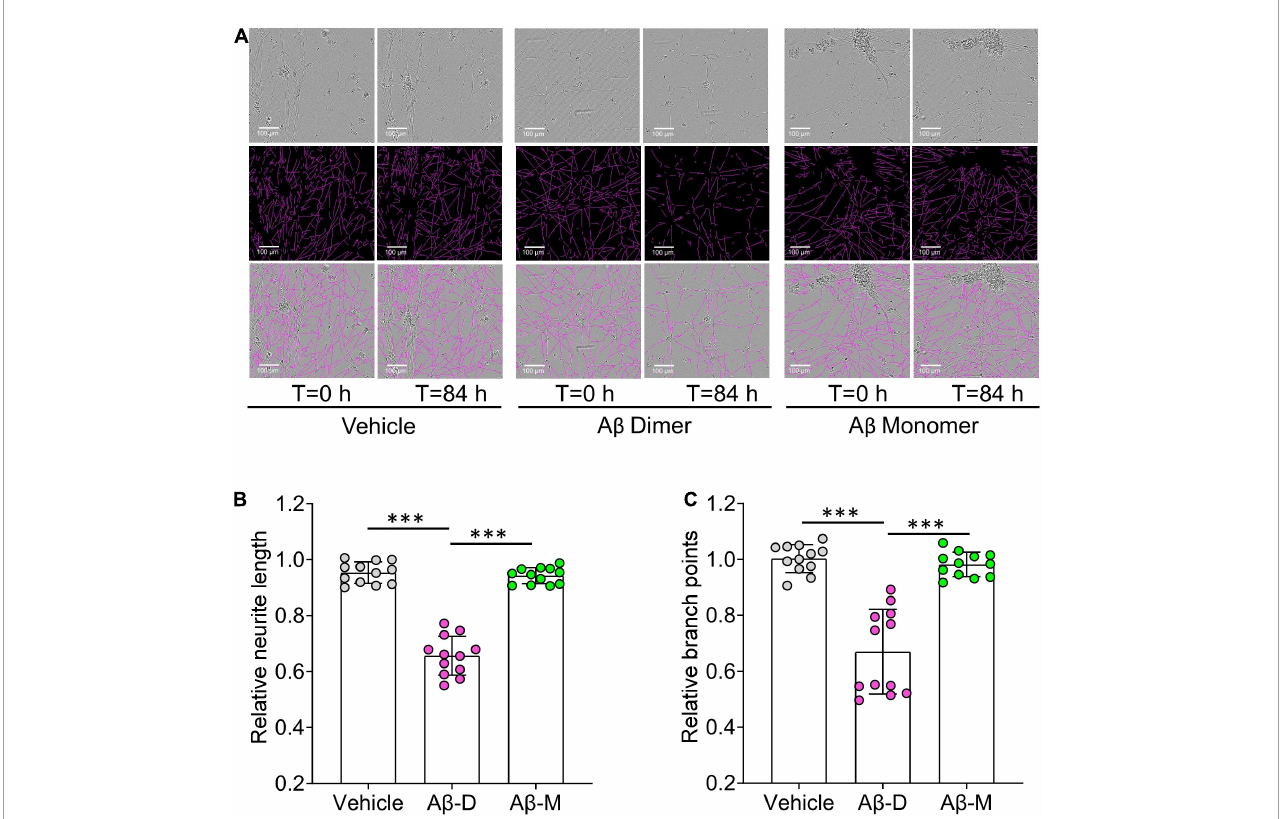
FIGURE6 Human brain derived A β dimers induce neuritic dystrophy when applied to iNs. (A) Mature human iPSC-induced neurons (iNs) were treated with vehicle, 22 nM of AD brain derived A β dimers (A β Dimer) or monomers (A β Monomer), and cells imaged using IncuCyte live-cell imaging instrument for 84 h. Phase contrast images (top panel) were used to identify neurites (middle panel) using NeuroTrack software. Identified neurites (purple) are shown on the phase contrast images (bottom panel). Scare bars are 100 µ m. (B,C) Each well of iNs was imaged for 6 h prior to addition of sample used as baseline. Relative neurite length and branch points at T = 0 and 84 h were normalized to corresponding baselines. Treatments were examined by one-way ANOVA and significant differences are denoted as ∗∗∗ p <